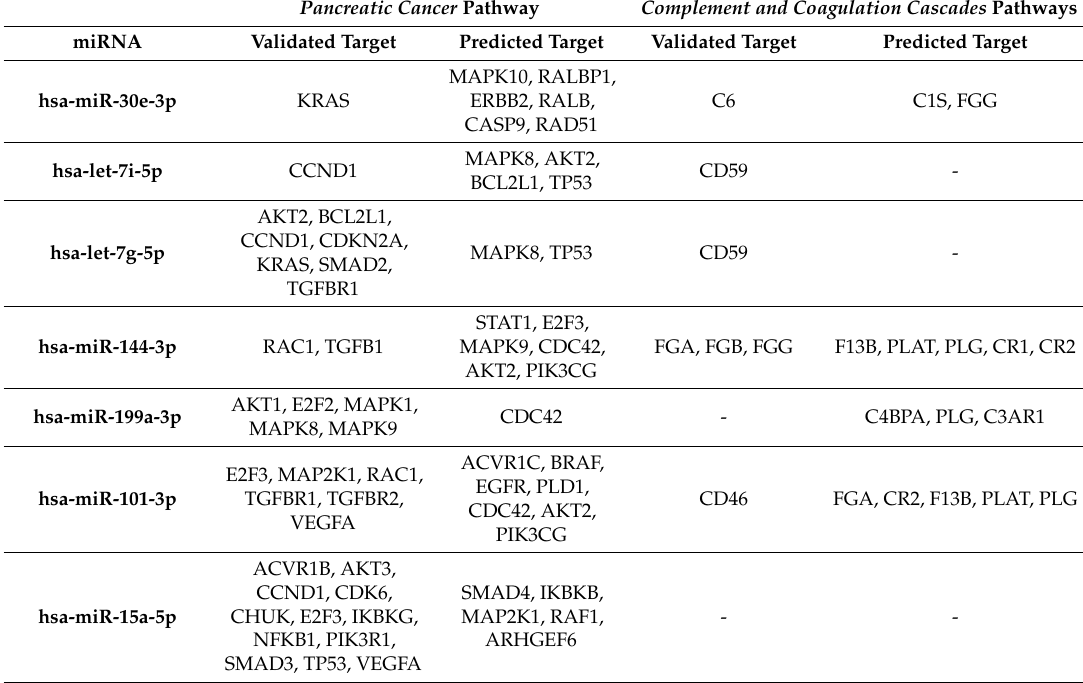
Table 5. Validated and predicted target genes of the 7 miRNAs down-regulated in the VTE group of patients in a sample right before the VTE event compared with the sample obtained at inclusion. These target proteins were identified using miRWalk 2.0 and were further integrated within the pancreatic cancer pathway and the complement and coagulation cascades pathway from KEGG. Validated targets are those that have been empirically validated to be regulated by a miRNA. Predicted targets are those that have been theoretically estimated based the free binding energy between a miRNA and a putative target mRNA